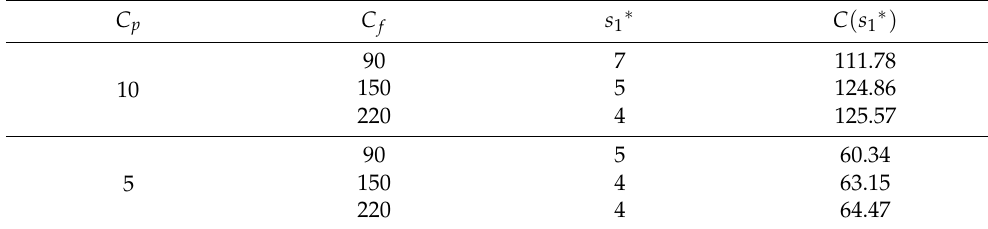
Table 3. Optimal quantities with different C p and C f